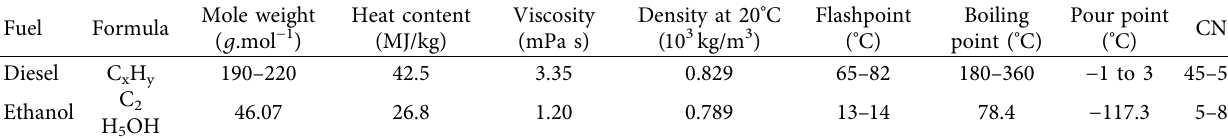
Table 1: Properties of diesel and ethanol [23].